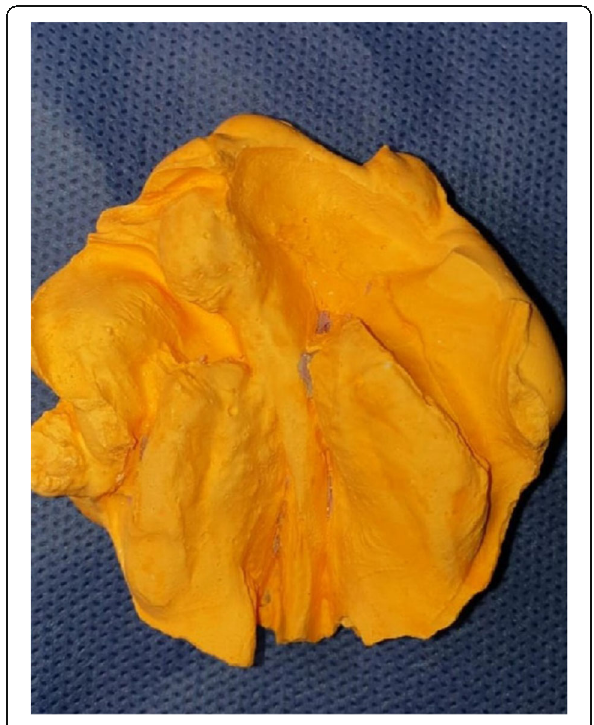
Fig. 2 Dental impression showing oral roof of one of the